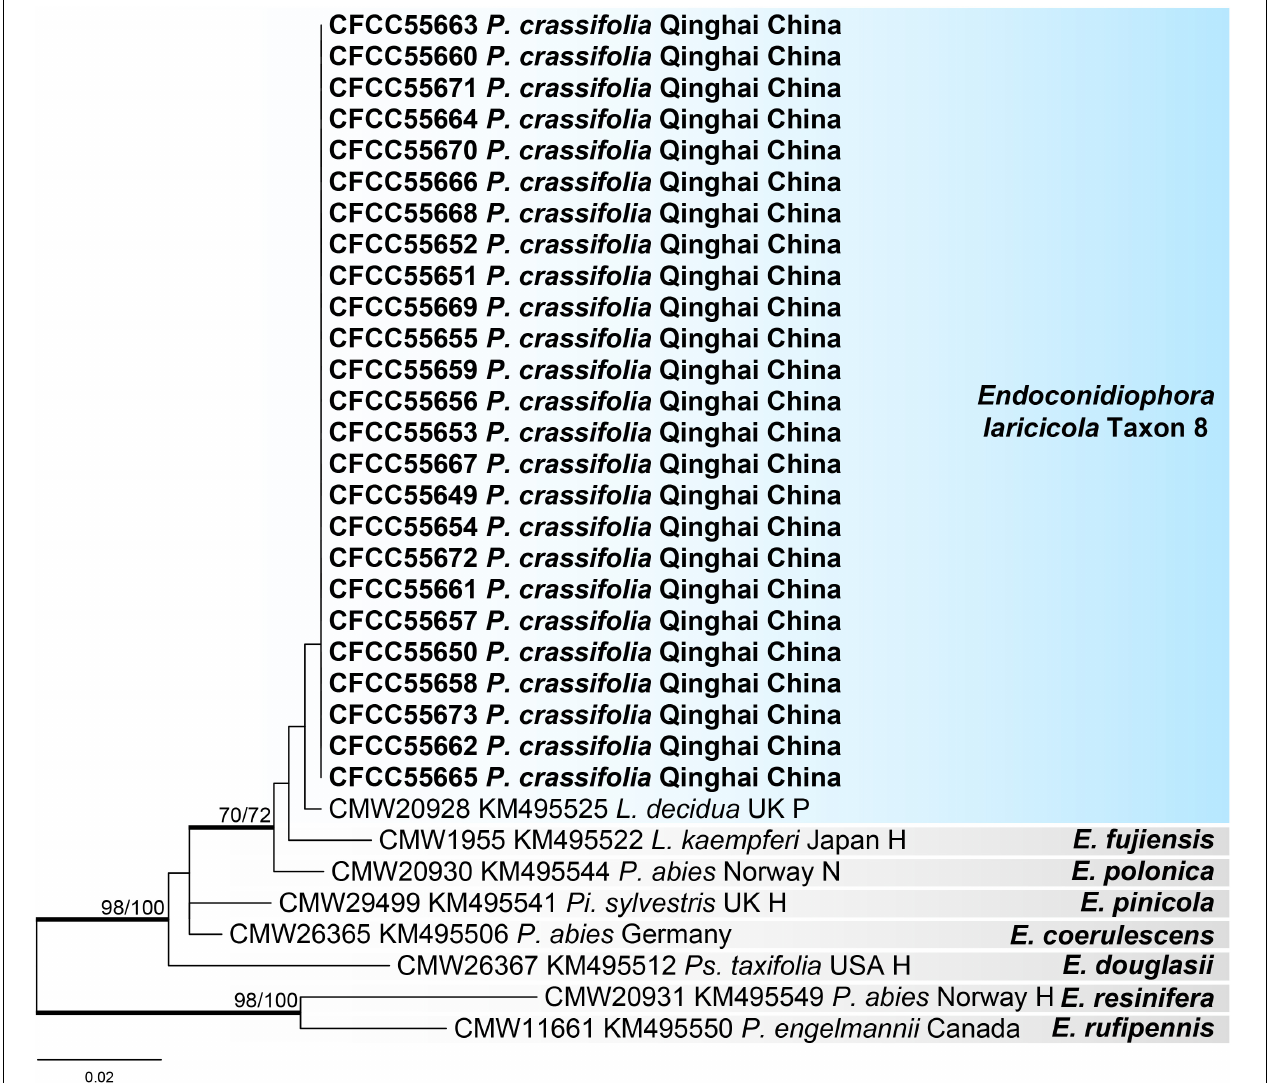
FIGURE 7 | Phylogram of Endoconidiophora (including taxon 8) based on 60S sequence data. Bold branches indicate posterior probability values ≥ 0.9. The MP/ML bootstrap support values ≥ 70% are recorded at the nodes. L ., Larix ; P ., Picea ; Pi ., Pinus ; Ps ., Pseudotsuga ; H, ex-holotype; N, ex-neotype; P, ex-paratype.